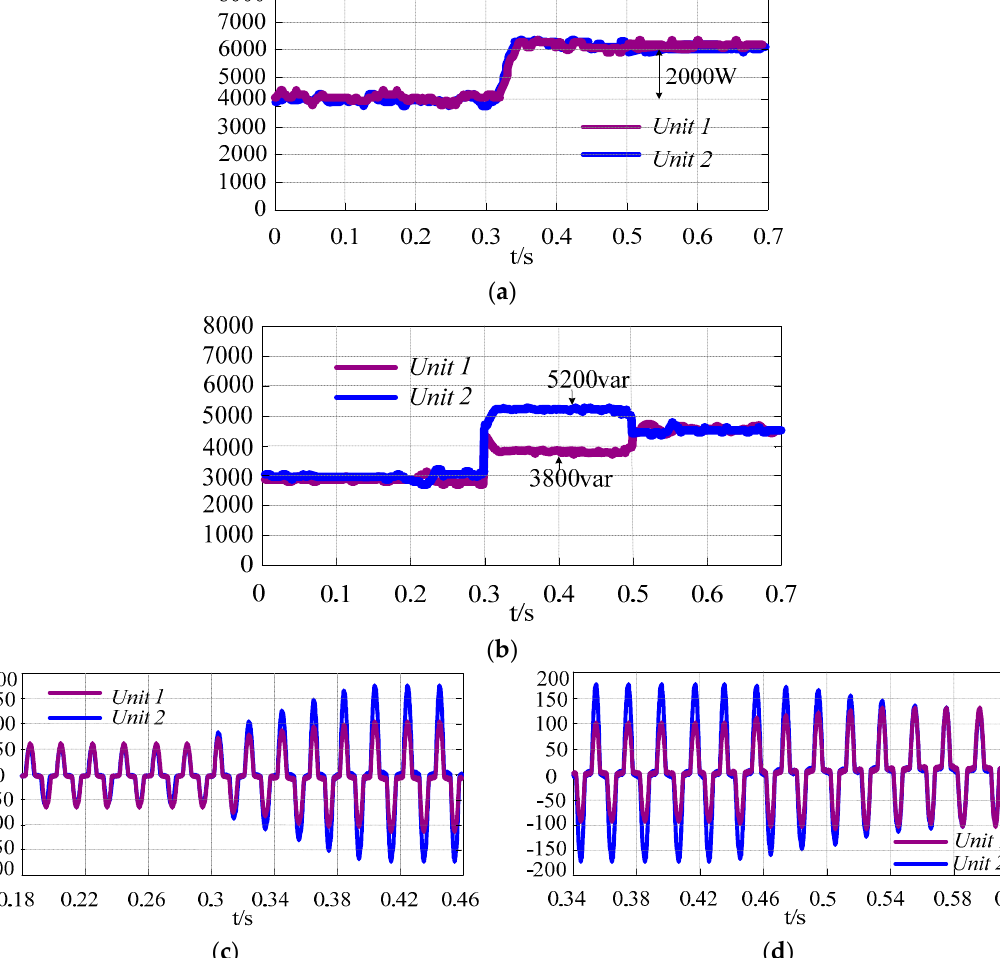
Figure 9. Simulation results of proposed method in simulation II. ( a ) The active power (W); ( b ) The reactive power (var); ( c ) The current waveforms of two inverters around 0.3 s (A); ( d ) The current waveforms of two inverters around 0.5 s (A).